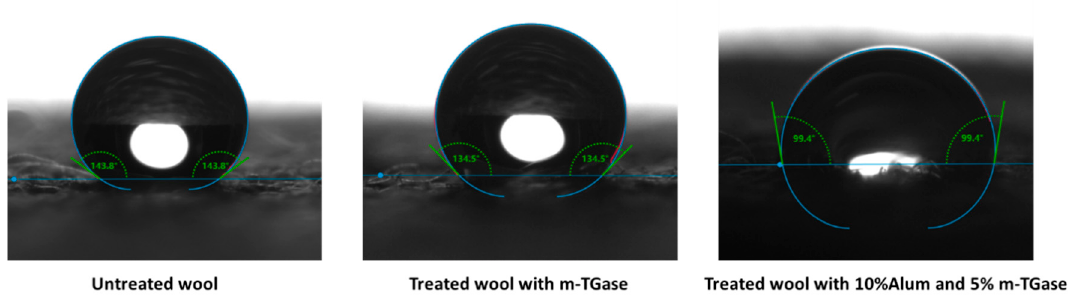
Figure 4. Water droplets on untreated wool; treated wool with 5% m-TGase; treated wool with 10% alum and 5% m-TGase.